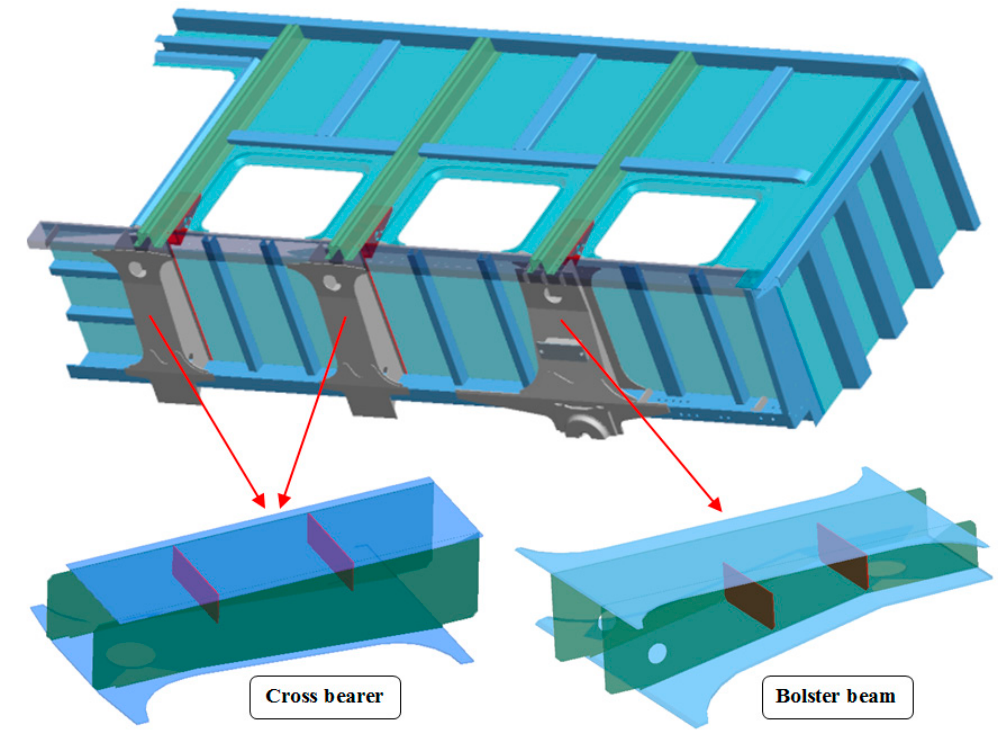
Figure 3. The structure of gondola car body and its key box girders .